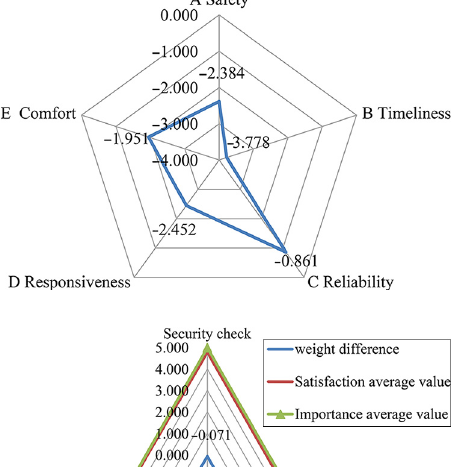
Figure 2. Weight differences of safety indicators